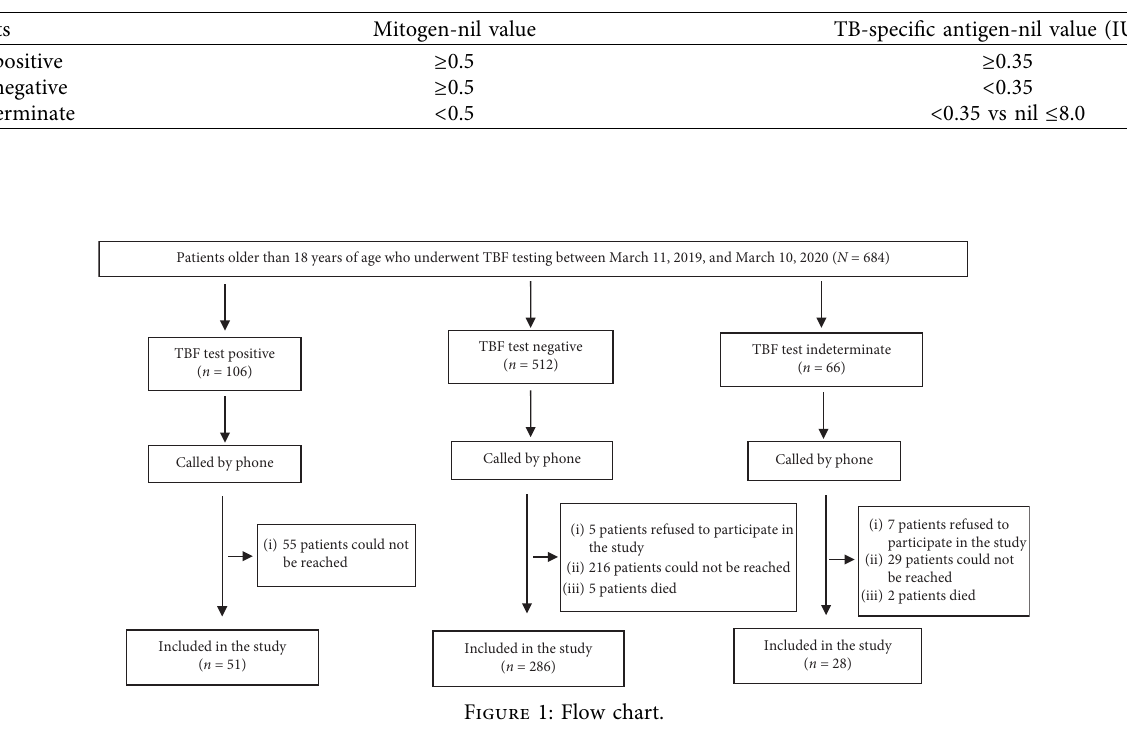
Table 1: Evaluation of TBF test.